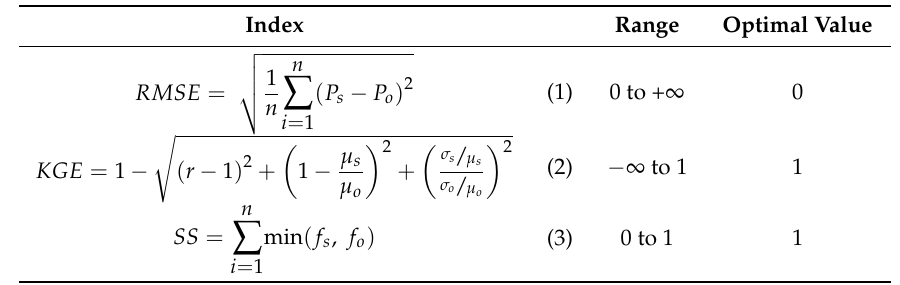
Table 3. Statistical indices used for the measurement of the performance of satellite precipitation products in estimating rainfall amount.